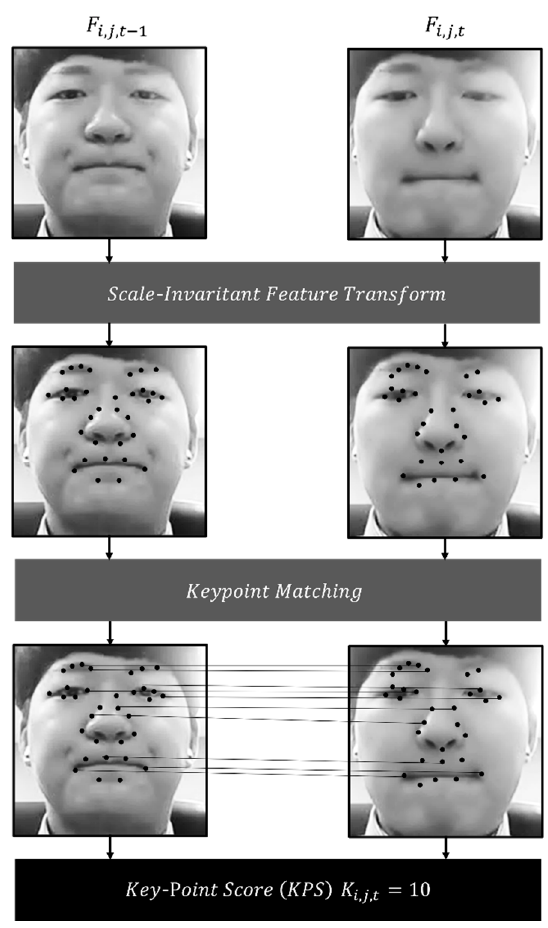
Figure 6. KPS score calculation from image changes. Table 5. Keypoint score on each time for item j.